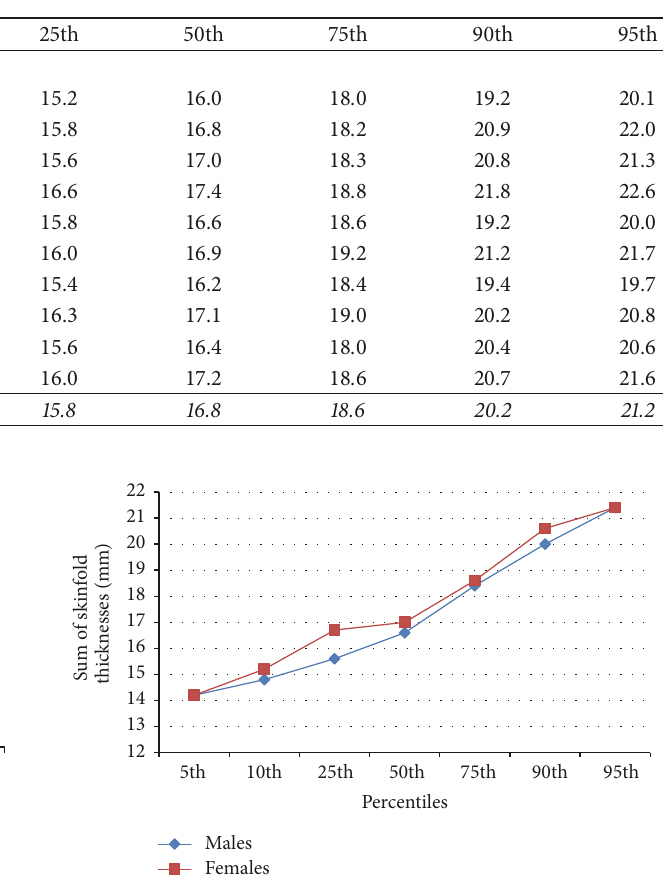
Table 6: Correlation coefficients between birth weight categories and skinfold measurements at various sites.